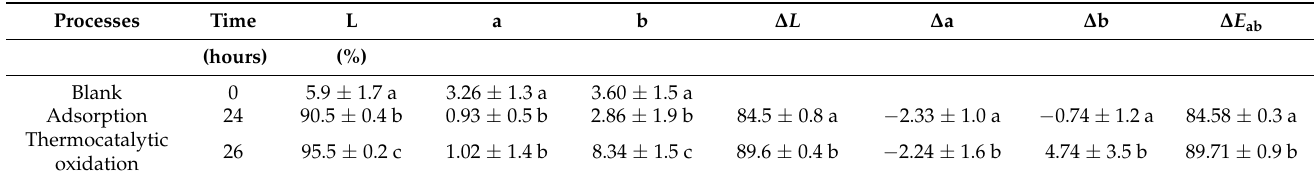
Table 5. Analysis of chromatic characteristics (CIELab) after adsorption process and combined adsorption–thermocatalytic oxidation processes. Adsorption operational conditions, as follows: [Na-Mt] = 5.0 g/L, pH = 3.0, V = 500 mL, agitation 350 rpm, T = 298 K, t = 24 h. Thermocatalytic oxidation conditions, as follows: S 2 O 2 − /H 2 O 2 ratio = 1:0.25, S 2 O 2 − /H 2 O 2 dosage = 0.1:0.025 ( g / g 8 8